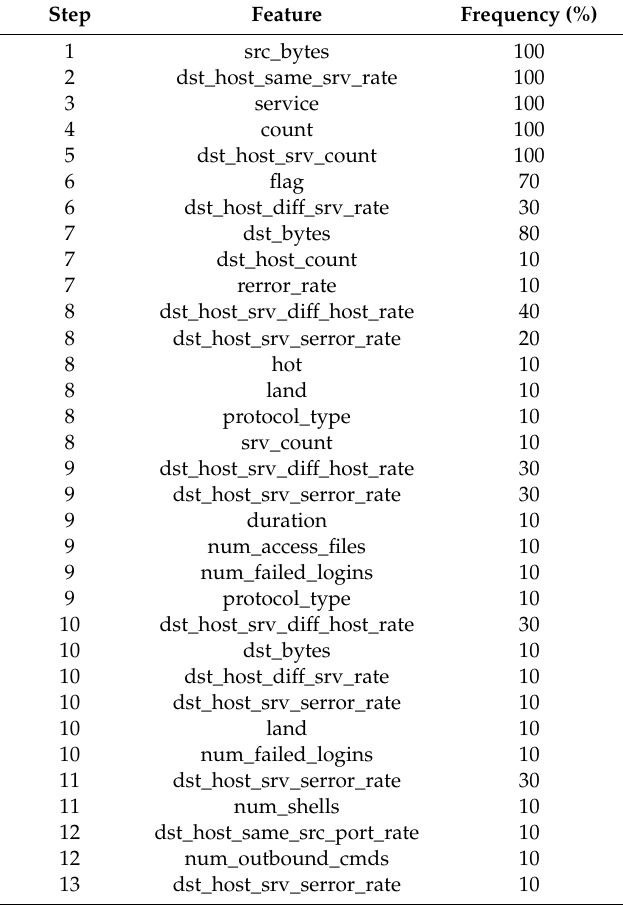
Table 5. The most frequent feature combinations—NSL-KDD dataset, 10 runs. For each step, the features that were selected at that step are listed with the percentages of their occurrences at that step among runs for the newly proposed